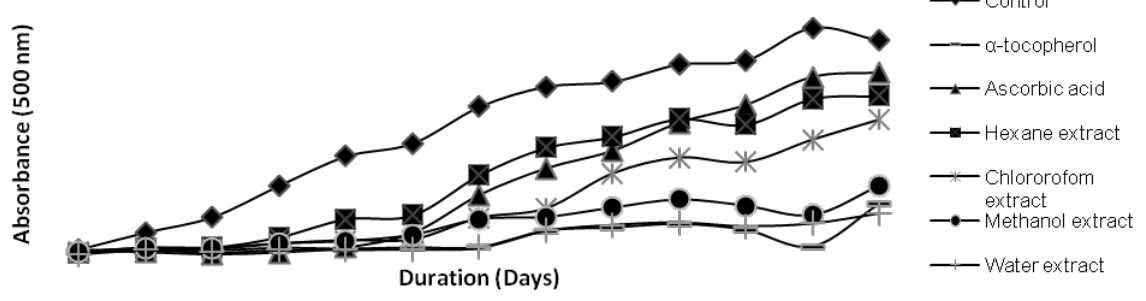
Figure 1. Antioxidant activity of kenaf seed extracts determined by FTC